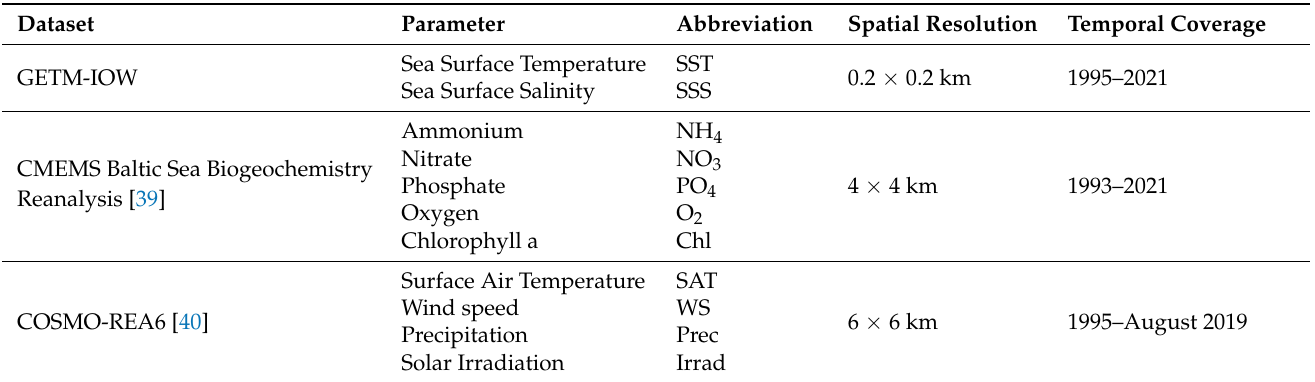
Table 1. Utilised datasets, environmental parameters, and their